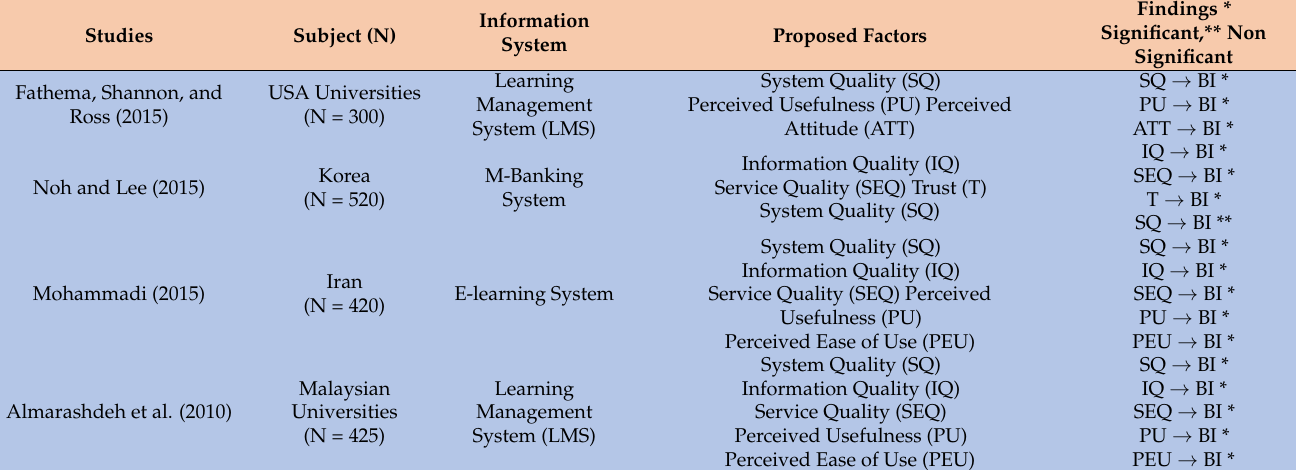
Table 1. Previous studies on the relationship between quality factors and behavioral intention